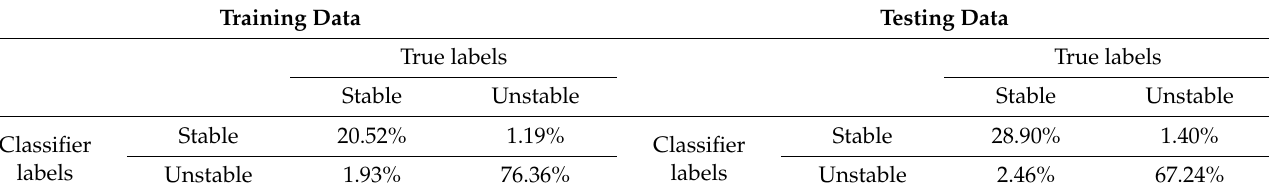
Table 2. DT confusion matrices on training and testing data.